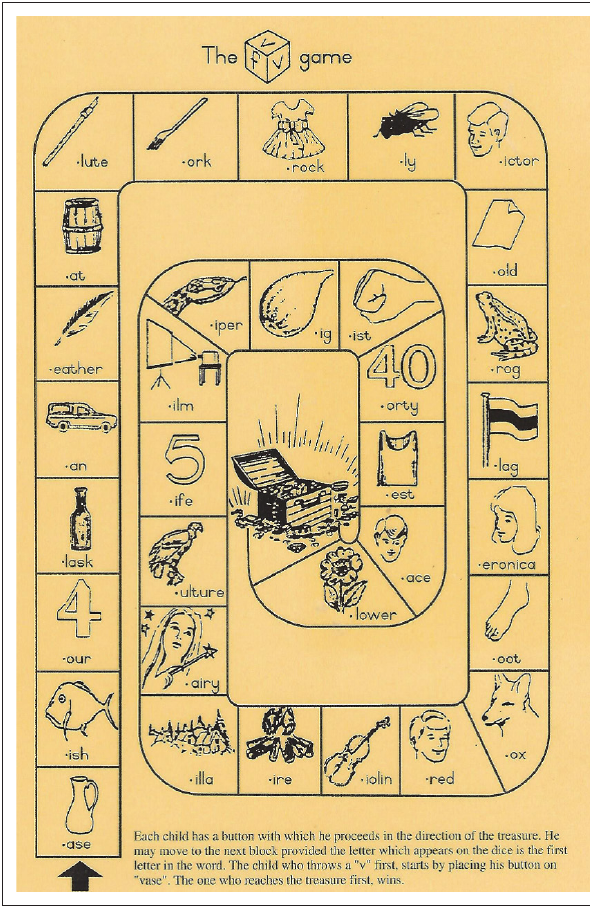
FIGURE 2: Worksheet prepared for Grade 3 to practise voiceless f and voiced v